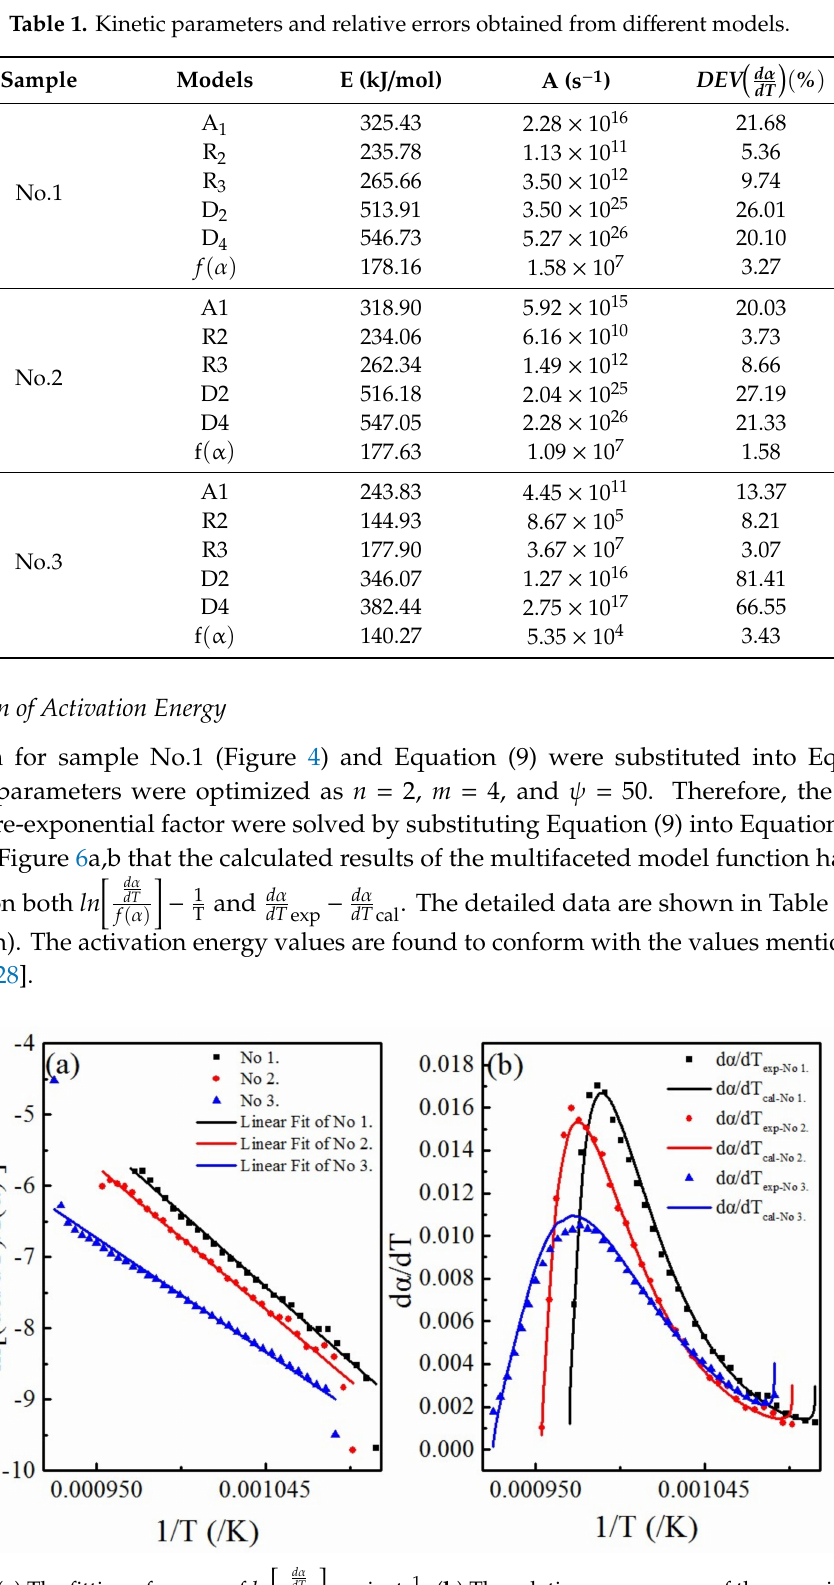
Figure 6. ( a ) The fitting of curves of ln and calculated